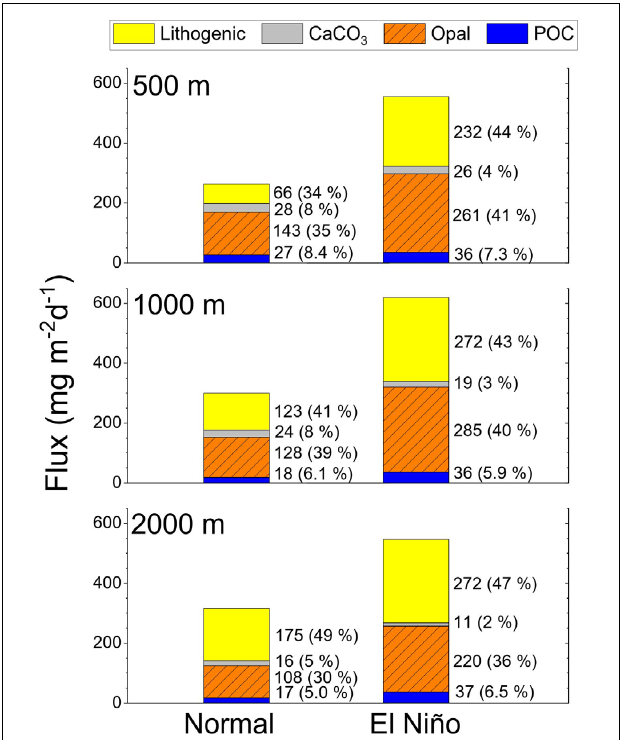
FIGURE 5 | Stacked bar plots of the biogenic and lithogenic material fluxes at the three sampling depths for the normal (non-EN) and EN periods (see Table 1 for delineation of these periods). The proportions (as%) of each component are included (in parentheses). Note that the height of the stacked bar is not exactly equal to the total particle flux.